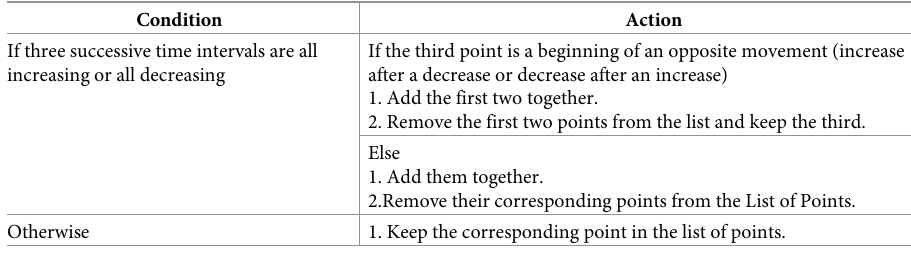
Table 1. Rule for minimizing salient